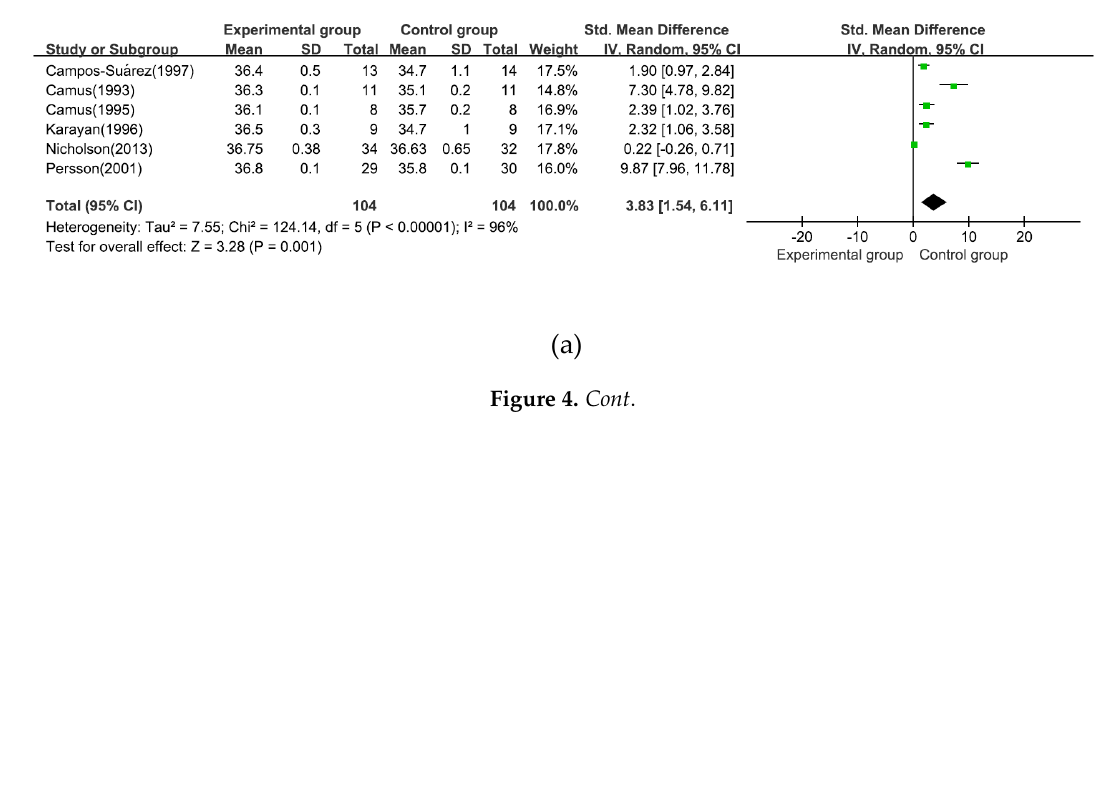
Figure 3. Risk of bias summary.